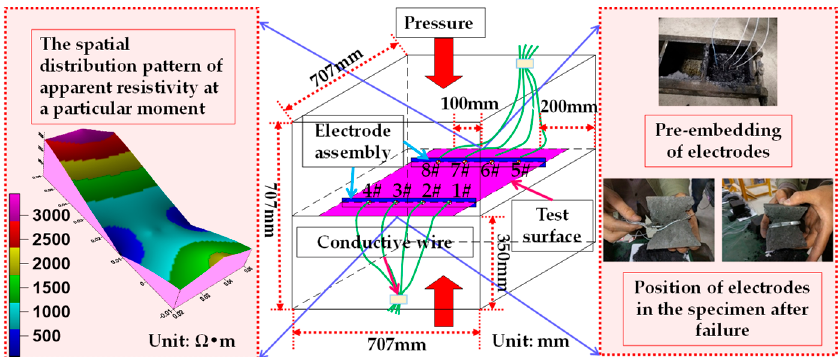
Figure 4. Arrangement of electrodes in specimens.